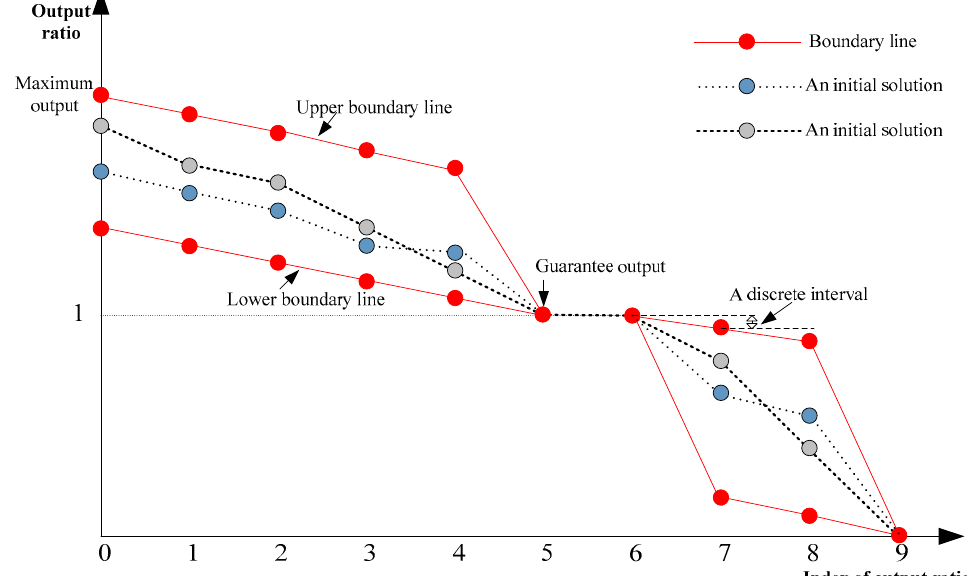
Figure 4. Possible space for initial solution of output coe ffi cients of Energy Storage Operation Chart (ESOC).